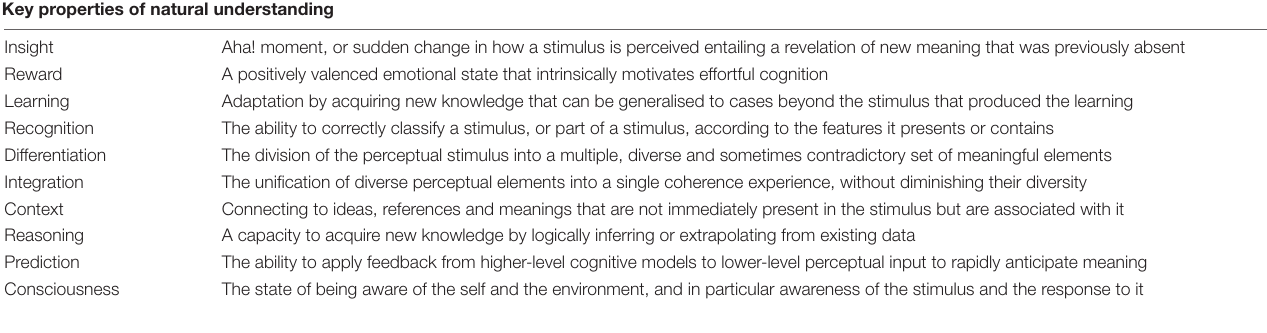
TABLE 2 | Summary of the key properties of natural understanding based on the cases of the remote associates task and the interpretation of a painting. Key properties of natural understanding